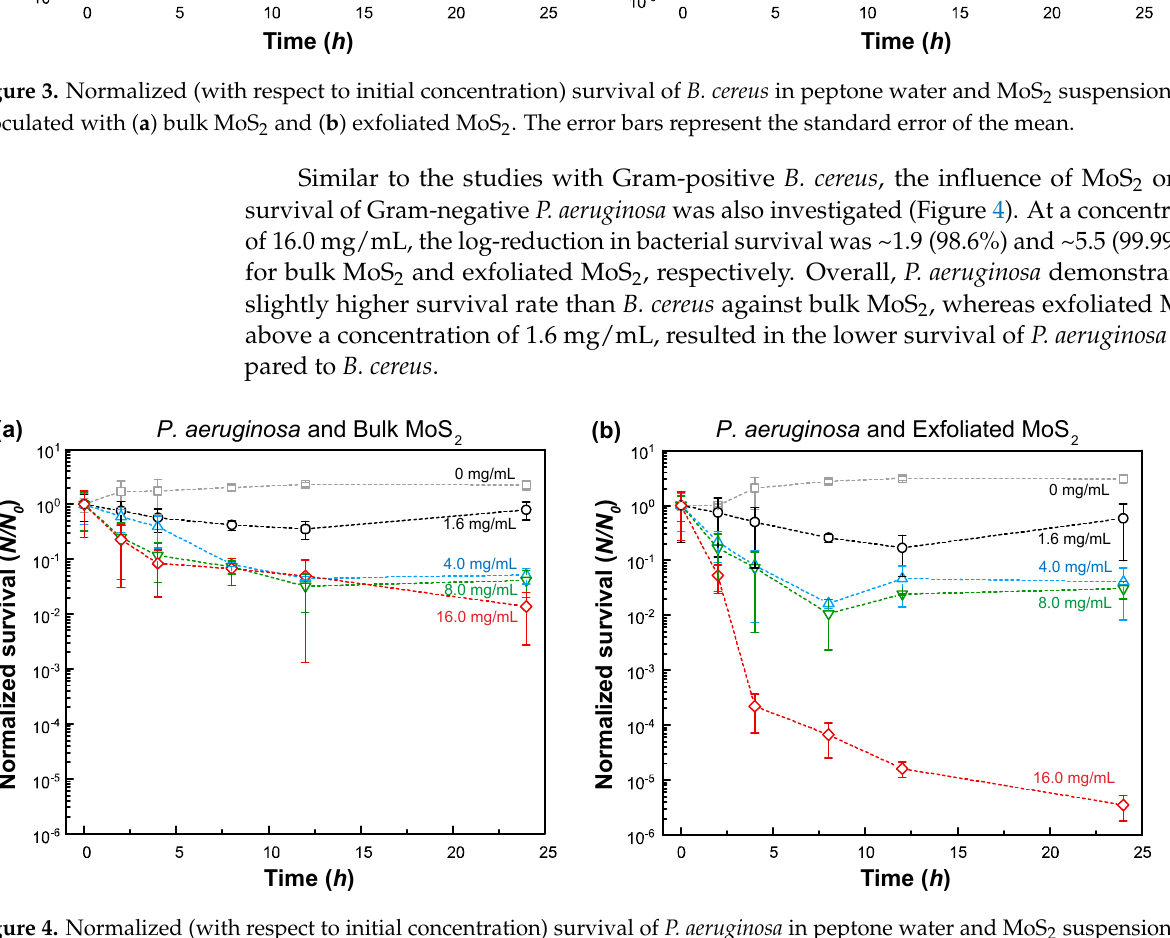
Figure 3. Normalized (with respect to initial concentration) survival of B. cereus in peptone water and MoS 2 suspension inoculated with ( a ) bulk MoS 2 and ( b ) exfoliated MoS 2 . The error bars represent the standard error of the mean.